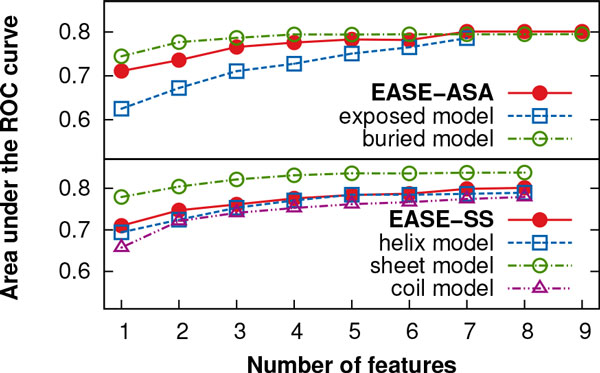
Feature selection progress. The area under the ROC curve (AUC) is shown as a function of the number features selected during feature selection. The prediction performance of the different models became more balanced as the feature selection progressed. These are cross-validation results with the S1676 data set.